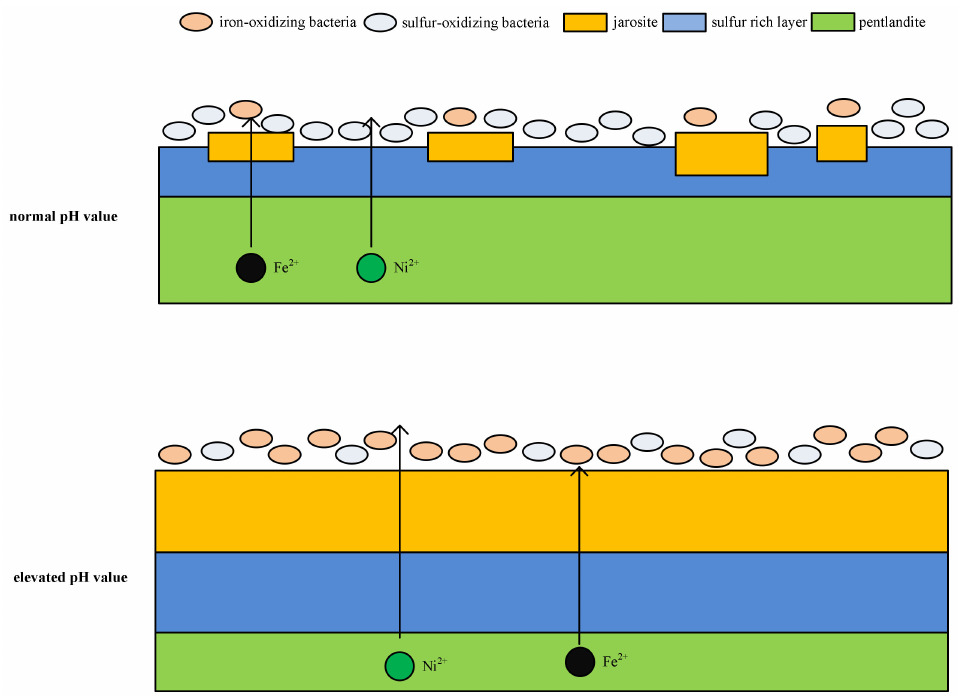
Figure 19. Di ff erences of mineral and leaching bacteria behaviors during pentlandite bioleaching with normal and elevated pH